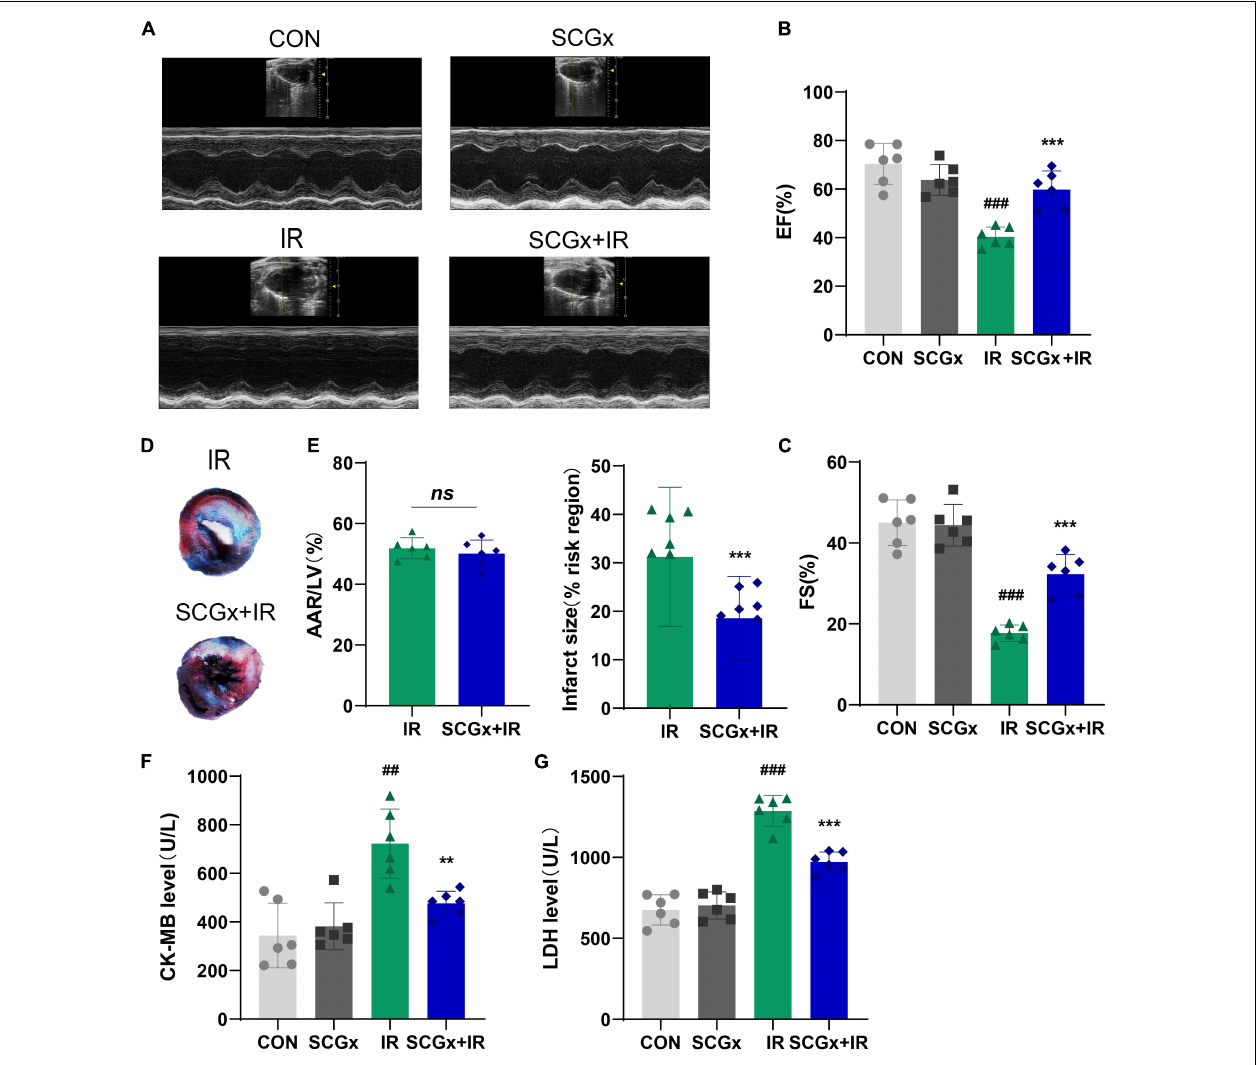
FIGURE 1 | Sympathetic denervation improves cardiac function in mice with myocardial I/R. (A–C) Representative M-mode echocardiography images. LVEF, left ventricular ejection fraction. LVFS, left ventricular fractional shortening. (D) Representative photographs of Evans blue and 2,3,5-triphenyltetrazolium chloride double-stained heart sections. (E) Quantitative analysis of the proportion of myocardial infarction area. (F,G) Detection of creatine kinase-MB (CK-MB) and lactate dehydrogenase (LDH) in mice serum. n = 6, 0.001 < ** P < 0.01 and *** P < 0.001 compared with the I/R group. 0.001 < ## P < 0.01 and ### P < 0.001 compared with the CON